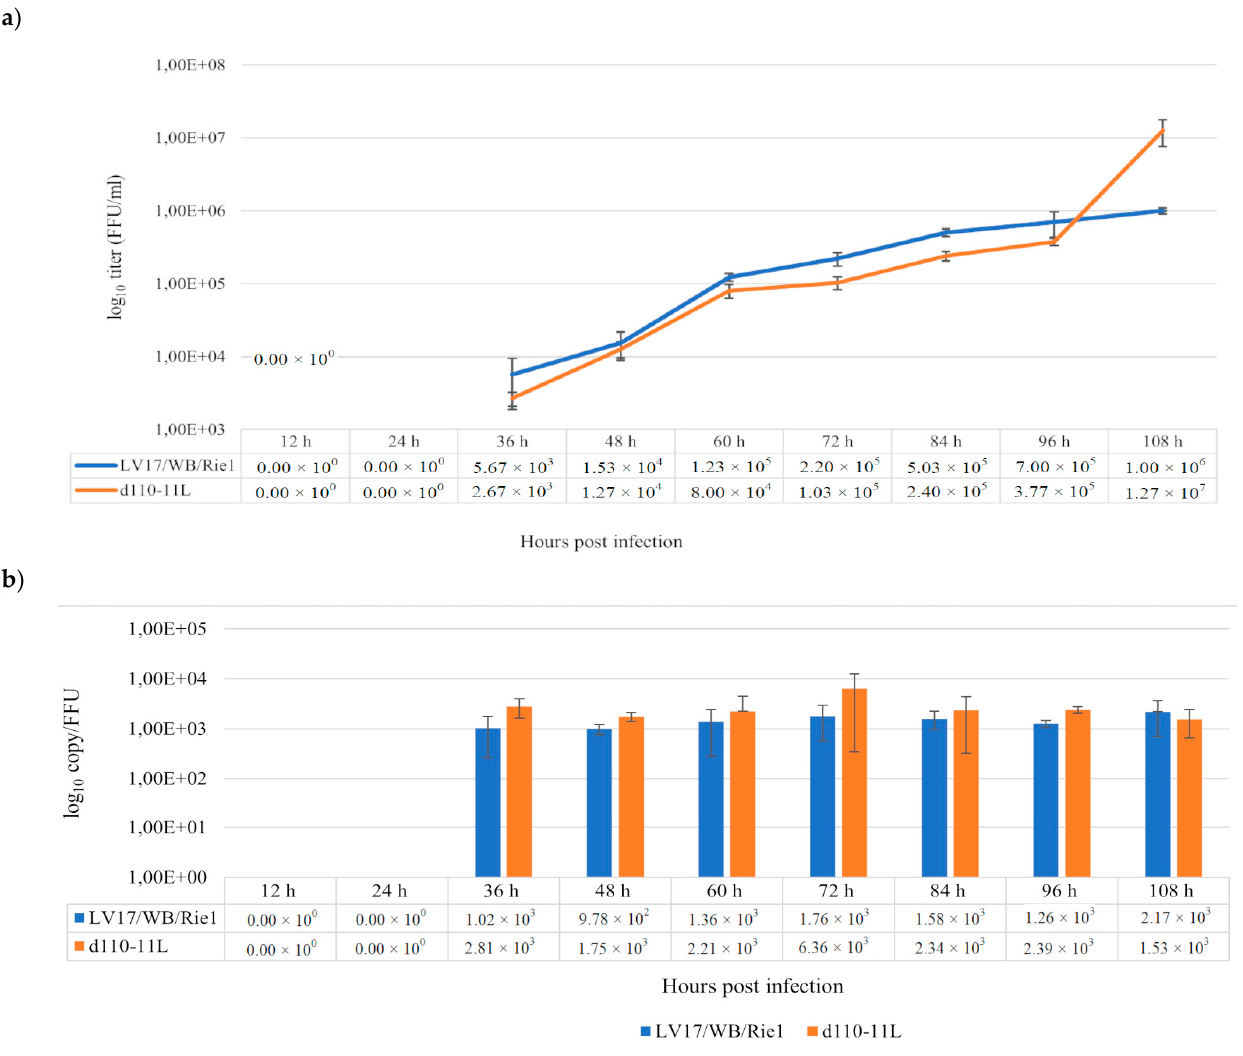
Figure 3 . Growth characteristics of parental LV17/WB/Rie1 and the mutant LV17/WB/Rie1/d110-11L viruses. Porcine alveolar macrophages were infected (MOI = 0.001), samples were collected every 12 h from 12 to 108 h, and virus yields were titrated. ( a ) Means and standard errors of three parallel experiments. ( b ) Changes in speci fi c infectivity (calculated as the ratio of genome copy/mL to FFU/mL).